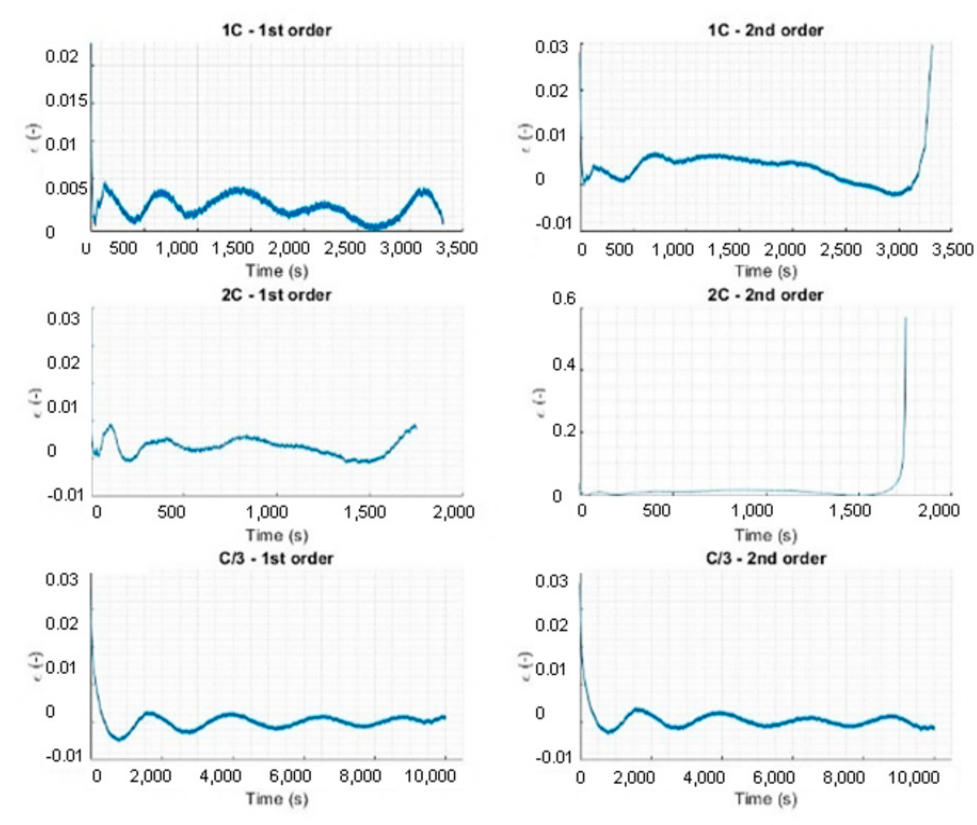
Figure 7. Simulation output error.